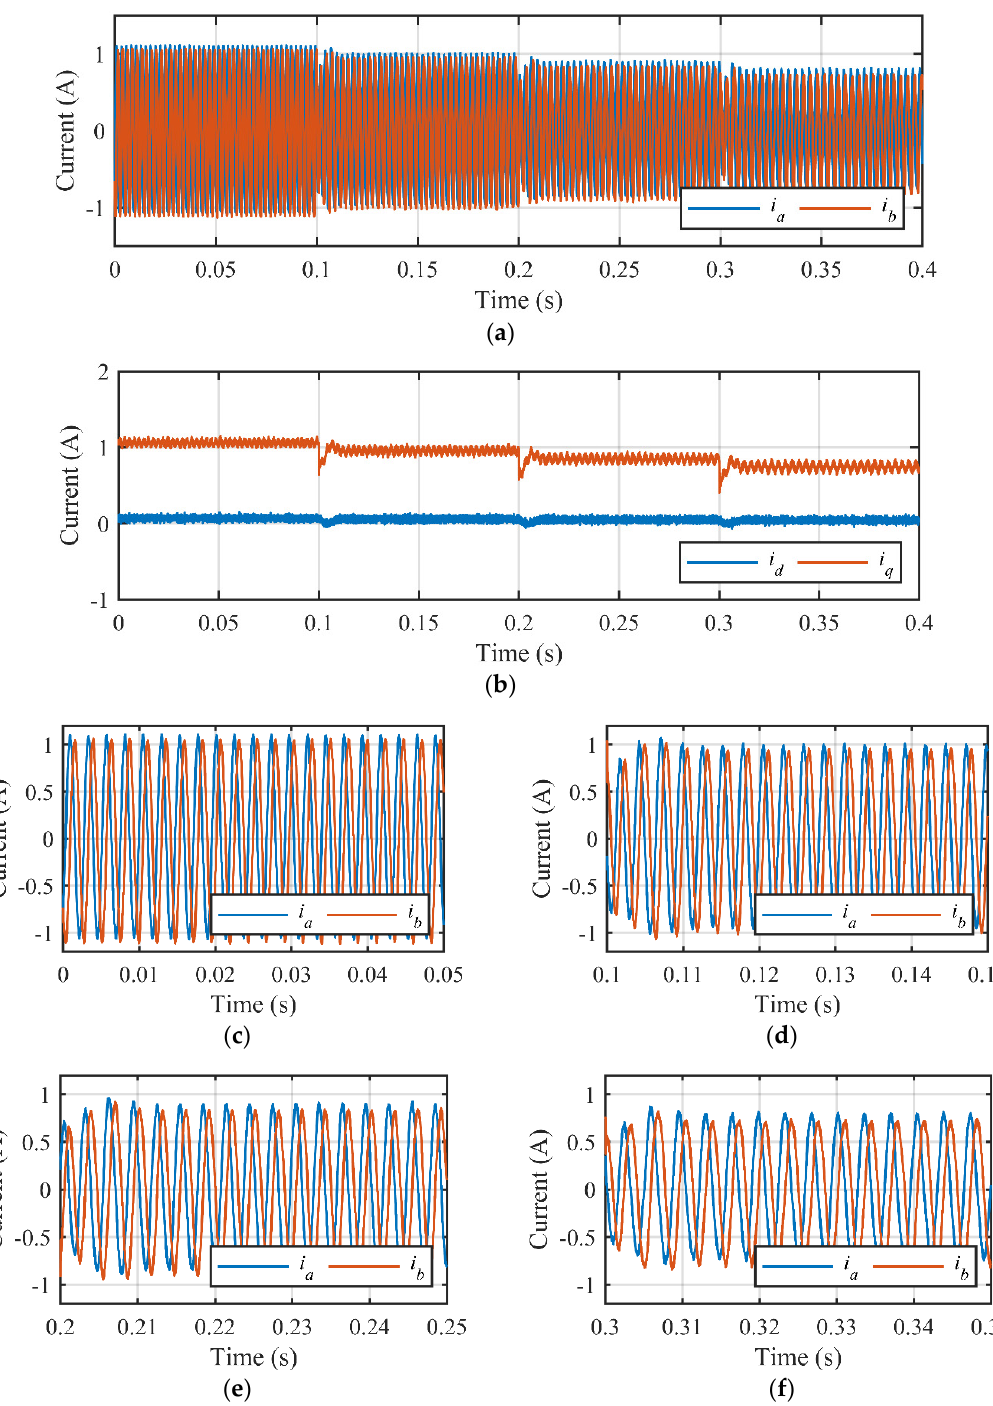
Figure 15. Experimental results of reference speed multi-step changes strategy, from 500 to 350 rpm, for ( a ) winding currents, ( b ) transformed currents in d-q coordinate, and the detail winding currents at ( c ) 500, ( d ) 450, ( e ) 400, and ( f ) 350 rpm.